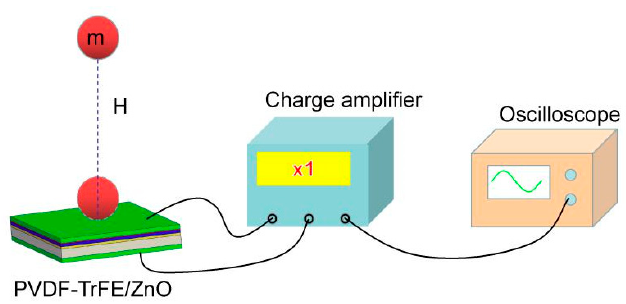
Figure 5. Schematic diagram of impact experiment.